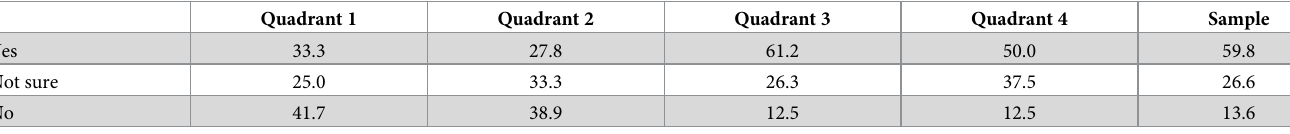
Table 6. I 3 vaccine classification and willingness to be vaccinated even if it only offers a few months’ protection.